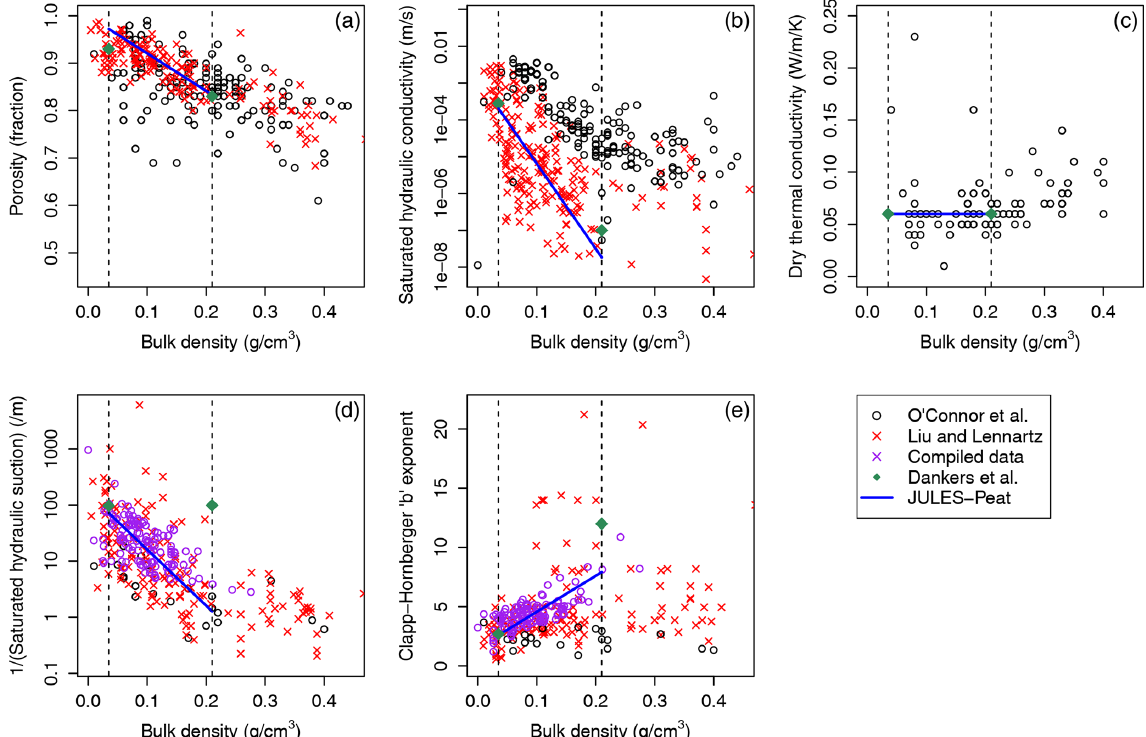
Figure 2. Functions used in JULES-Peat. Vertical dashed lines show the range of data that were used to fit the functions. These correspond to the minimum and maximum bulk densities for organic material that we derived for use in JULES ( ρ dpmrpm and ρ biohum ; Sect. 2.3). The additional literature data for saturated hydraulic suction and the Clapp–Hornberger exponent shown in purple were derived from the following papers: Londra (2010), Rezanezhad et al. (2012), Da Silva et al. (1993), Weiss et al. (1998), Päivänen (1973), Boelter (1964), Rydén et al. (1980) and Schwärzel et al.